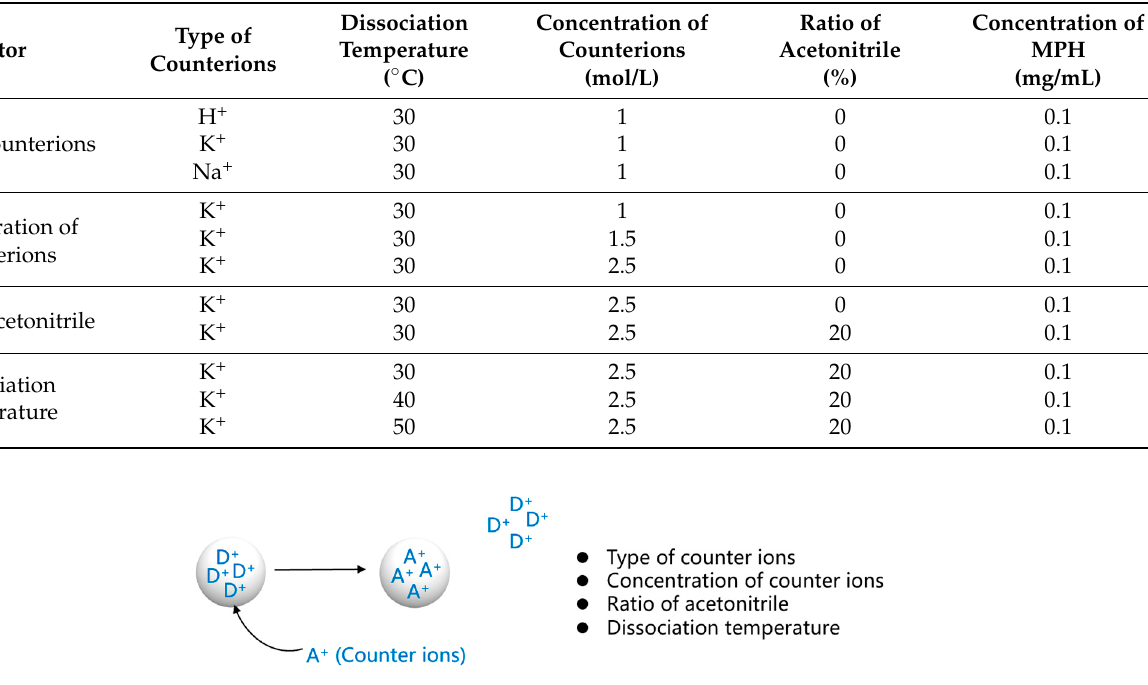
Table 2. Study of factors affecting the dissociation process.